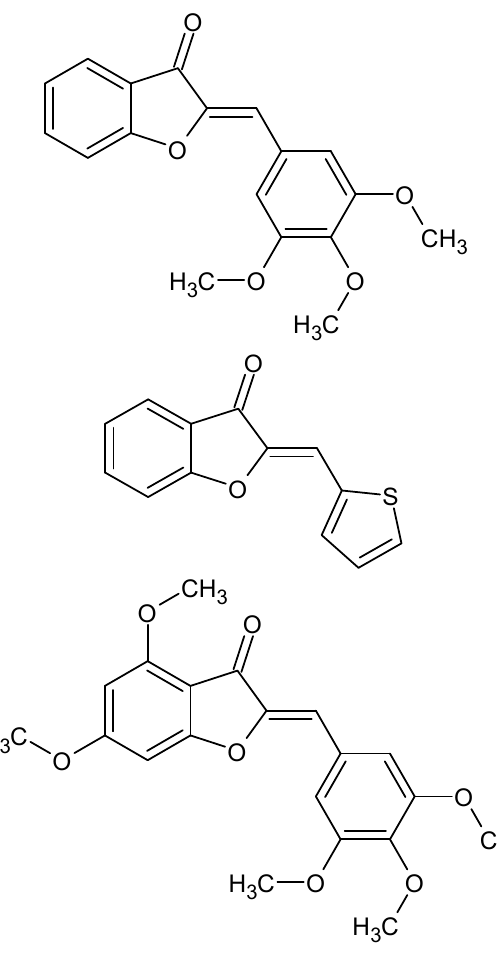
Figure 6. The structures of the three most active aurone analogs.